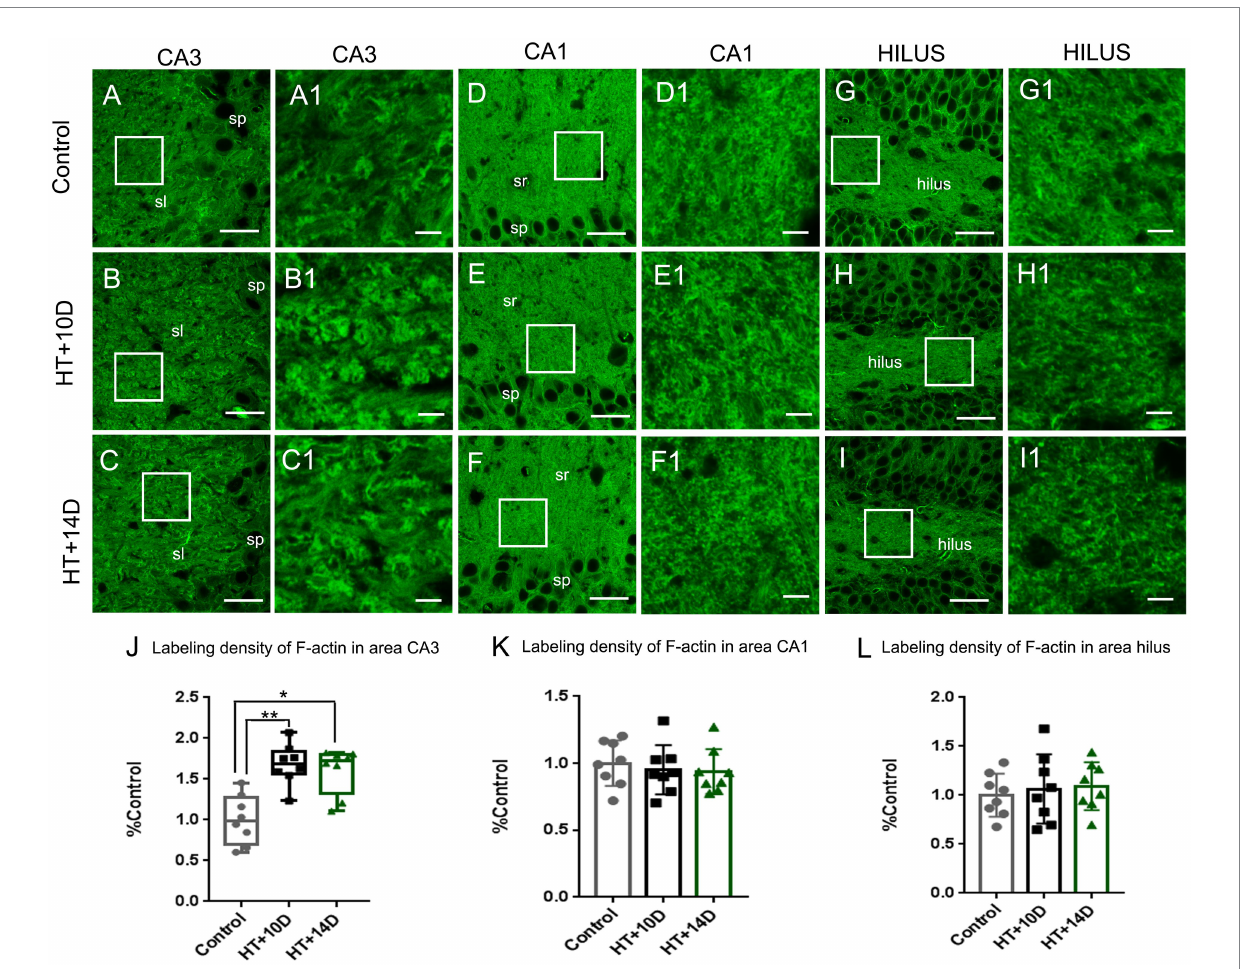
FIGURE 2 The rearrangement of F-actin cytoskeleton in subregions of hippocampus after experimental febrile seizures. Scale bars: (A–I) 30 μ m; (A1–I1) 5 μ m. Images (A–I) show the distribution of F-actin in the hippocampal CA3 region, CA1 region and hilus of DG in the control, HT + 10D and HT + 14D groups, respectively. Images (A1–I1) are enlarged from the insets of images (A–I) . Compared with that of control group (A,A1) , the labeling density of F-actin increases remarkably in the stratum lucidum of subregion CA3 after experimental febrile seizures ( B,B1 for HT + 10D, C,C1 for HT + 14D, J for statistical analysis). While no significant difference is detected between the control group and HT+ groups in subregion CA1 ( E,E1 for HT + 10D, F,F1 for HT + 14D, K for statistical analysis) and hilus of DG ( H,H1 for HT + 10D, I,I1 for HT + 14D, L for statistical analysis). Further comparisons of F-actin labeling density in subfields CA3, CA1, and hilus of DG between group HT + 10D and HT + 14D show no significant difference ( n = 8 per group; * p < 0.05, ** p <